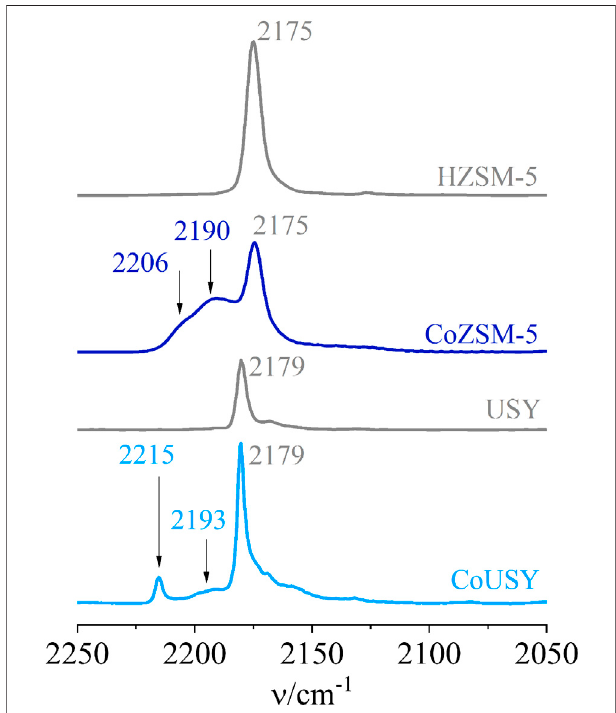
FIGURE 6 | IR spectra of CO sorption for the CoUSY and CoZSM-5 catalysts as well as reference zeolite supports.